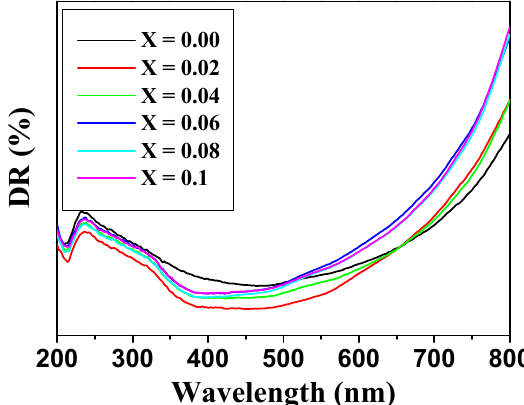
Figure 6. DR% spectra of the Co 0.5 Ni 0.5 Nb x Fe 2 − x O 4 (0.0 ≤ x ≤ 0.10) nanoparticles.